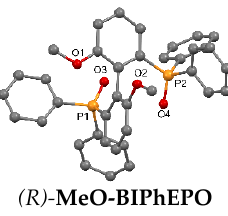
Figure 4. The CD spectra of (S) ‐ ( ‐ ) ‐ BICLPO (black) and (R) ‐ MeO ‐ BIPhEPO (red) recorded in CH 3 CN.